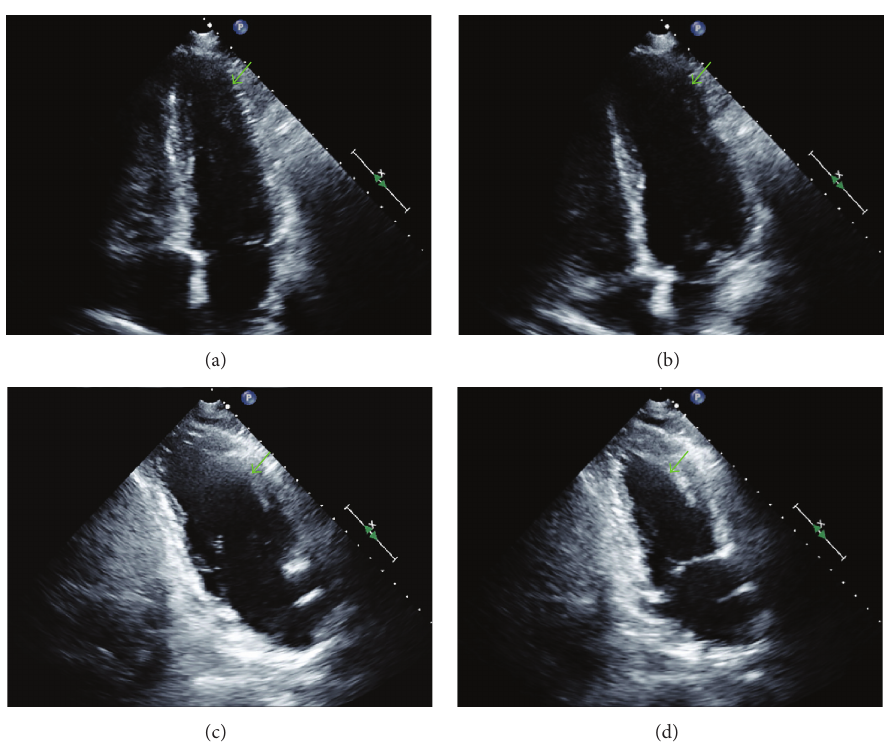
Figure 3: Repeat transthoracic echocardiogram confirming complete recovery of ventricular systolic function and resolution of the acute wall motion abnormalities, supporting the diagnosis of stress cardiomyopathy. Systolic (a) and diastolic (b) apical 4-chamber views and systolic (c) and diastolic (d) apical 2-chamber views reveal normal motion of the ventricular apex